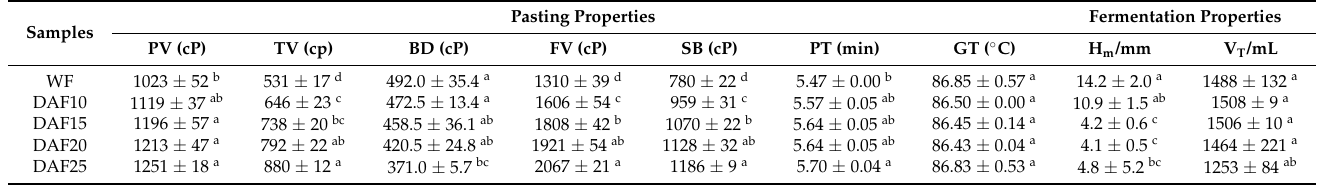
Table 2. Pasting and fermentation parameters of wheat flour with different substitution levels a,b,c . Pasting Samples